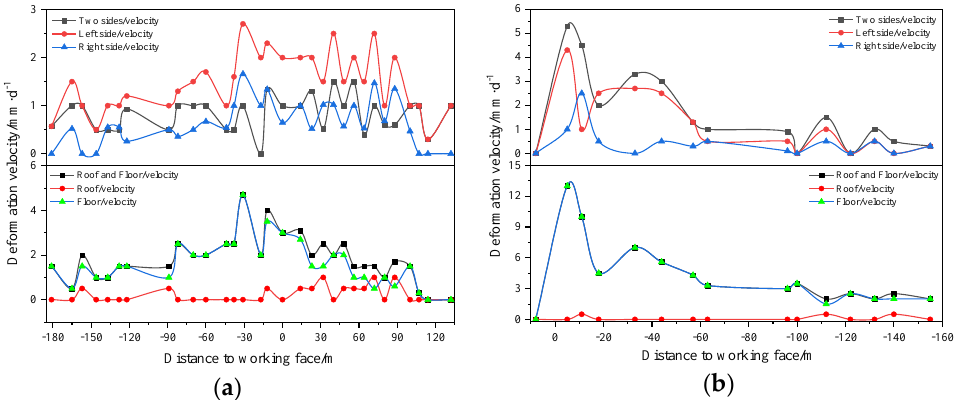
Figure 8. Comparison of deformation velocity of roadway surrounding rock ( a ) measuring point 5# ( b ) measuring point details are shown in Figure 8.